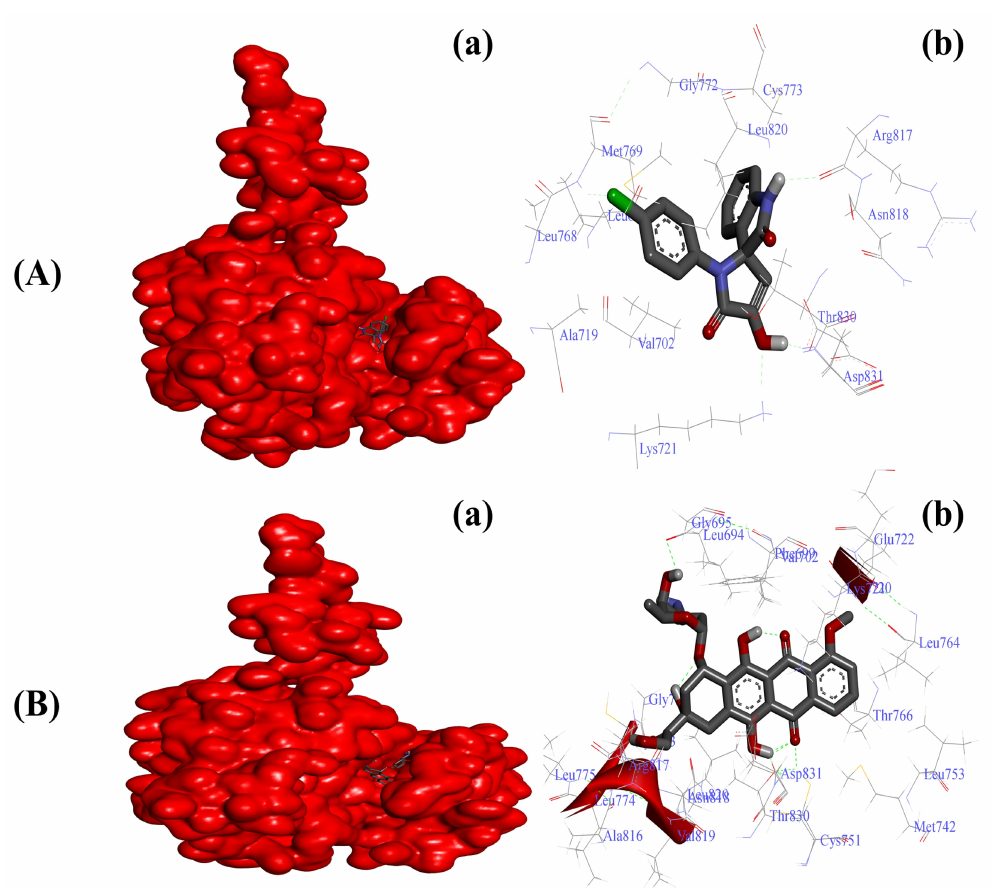
Figure 3. Substituted SOX ( 4a ) is a potent inhibitor of the tyrosine kinase domain of the EGFR (PDB ID:1M17). ( A ) Binding pattern of the substituted SOX ( 4a ) against human EGFR ( ∆ G: − 6.55 Kcal/mol); ( B ) Binding pattern of doxorubicin against human CD44 ( ∆ G: − 10.11 Kcal/mol). Subpan- els ( a ) represent the interaction of 4a and doxorubicin inside the active pocket of the target protein (represented as a red surface). Subpanels ( b ) show the 2D image of the interacting residues of the EGFR with our